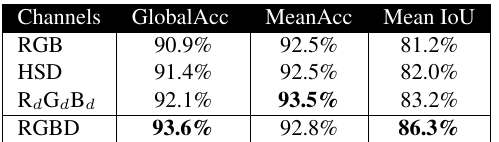
Table 3. IoU per class in test T1 (50% of the dataset for training and 50% for